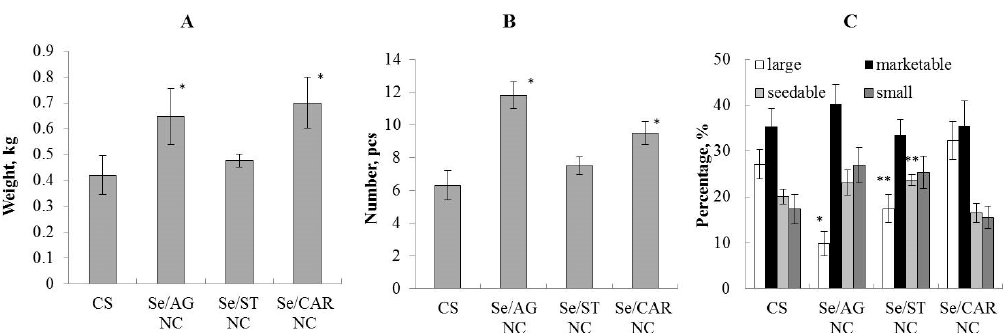
Figure 10. Effect of the Se NC treatments (with 105.57 µ g/mL for Se/AG NC, 428.08 µ g/mL for Se/ST NC, and 170.30 µ g/mL for Se/CAR NC, which corresponds to the Se concentration of 6.25 µ g/mL in the final solution) on the average weight of potatoes ( A ) and number of tubers ( B ) per plant, and crop structure ( C ). Large tubers weighed 150 g or more; commercial (marketable)—85–150 g; seed—50–80 g; small—less than 50 g; * p < 0.01, ** p < 0.05 (in comparison with CS) based on 3 plots per each Se NC and